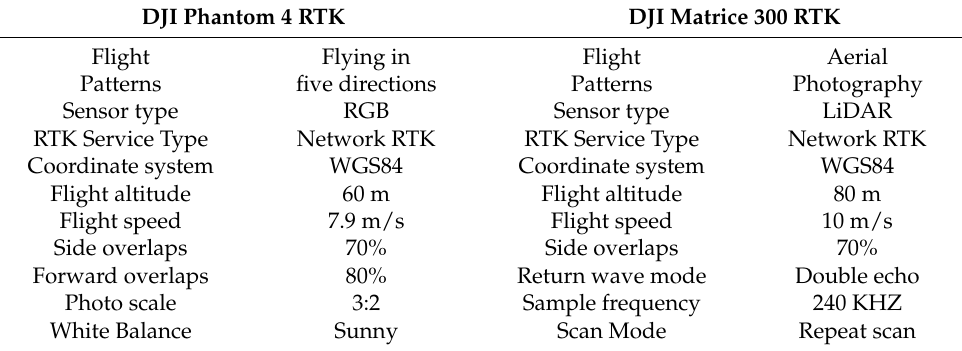
Table 2. Flight Parameters for UAV LiDAR and stereo image